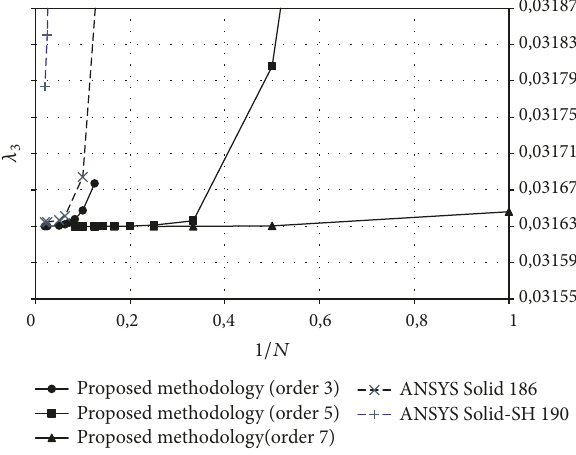
Figure 22: Free beam: